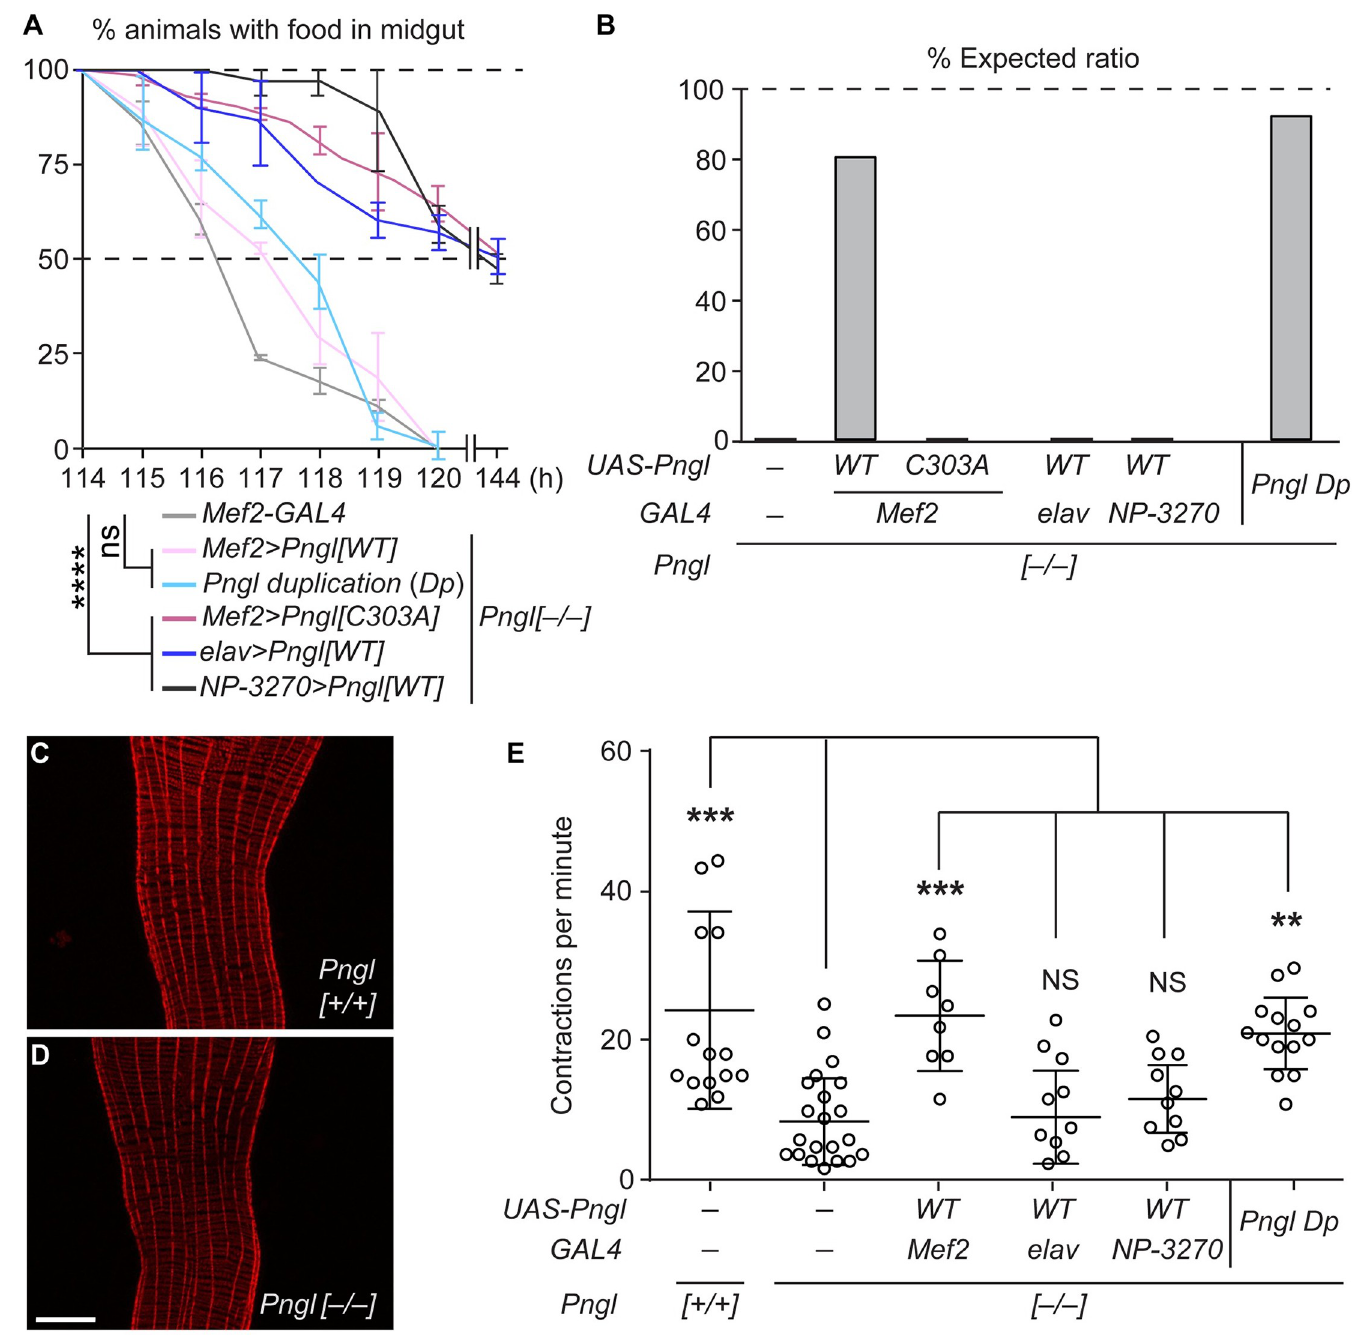
Fig 1. The food accumulation phenotype in Pngl mutants is associated with gut peristalsis defects and is rescued by mesoderm-specific enzymatic activity of Pngl. (A,B) Gut clearance assays in 3rd instar larvae and lethality rescue assays of the indicated genotypes are shown. The x-axis shows hours (h) after egg laying. The food accumulation phenotype (A) and the lethality (B) of Pngl mutants is rescued by a Pngl genomic duplication ( Pngl Dp ) and by overexpressing wild-type ( WT) Pngl by a mesodermal driver ( Mef2-GAL4 ) but not by expressing an enzymatic-deficient Pngl mutant ( C303A ) in the mesoderm or by expressing Pngl WT using neuronal ( elav- GAL4 ) and endodermal ( NP-3270-GAL4 ) drivers. Data in (A) represent mean ± SD of three independent experiments. Animal numbers in (B) are 200, 240, 160, 130, 193, and 145 from left to right. (C,D) Representative images of midguts of y w control (C) and Pngl –/– (D) larvae stained with phalloidin (red) do not show gross morphological defects in the mutant visceral muscle. The scale bar in D is 50 μ m and applies to (C) as well. (E) Midgut contraction frequencies per minute in Pngl –/– larvae is significantly reduced compared to control animals and is rescued by Pngl Dp and mesodermal but not neuronal or endodermal overexpression of Pngl WT . Each circle represents a larva. Significance is ascribed as �� P < 0.01 and ��� P < 0.001. NS, not significant.